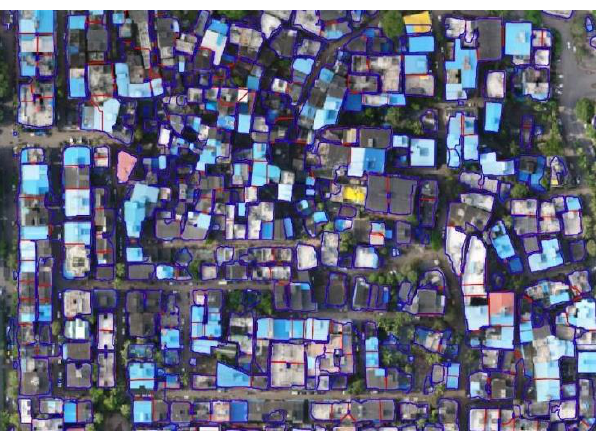
Figure 8 . 4 Dataset from Mumbai ( Indshine, 2018 ) Unstructured building dataset taken from UAV near Mumbai slums region . Blue boundary is raw detection without post - processing . Red boundary represents where polygon is divided into parts